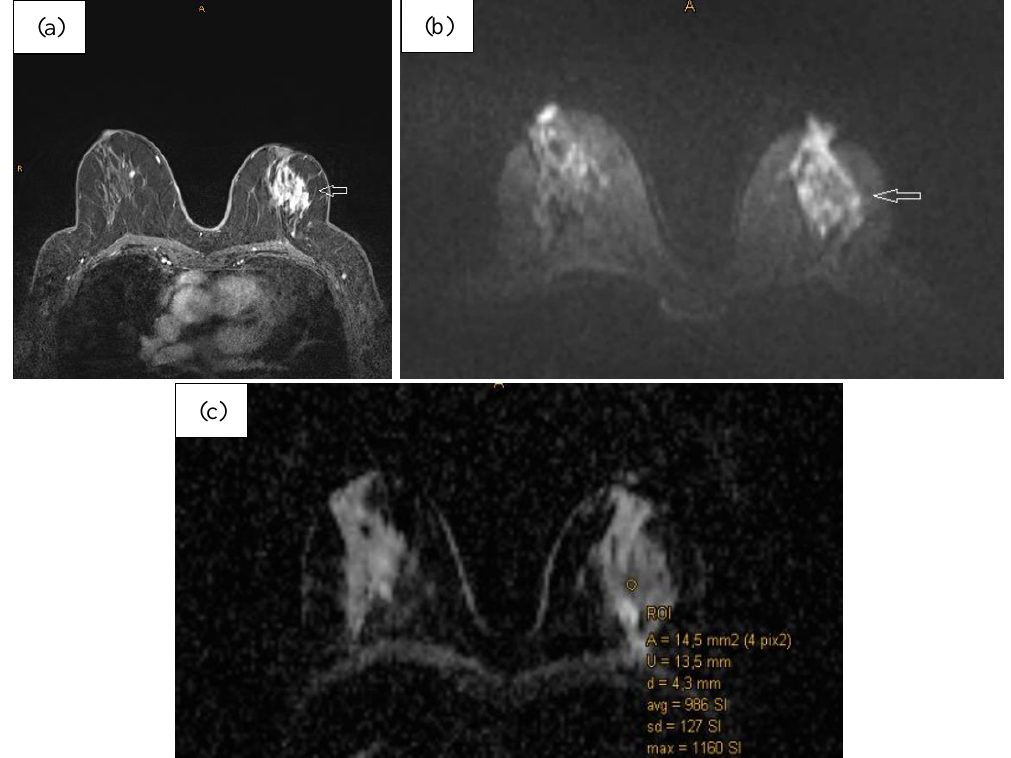
Figure 1. MRI of the breast: 64-year-old woman with lobular invasive carcinoma. Axial T1-weighted contrast-enhanced image (a) shows regional heterogeneous enhancement in left breast (arrow). Corresponding diffusion-weighted image (b=